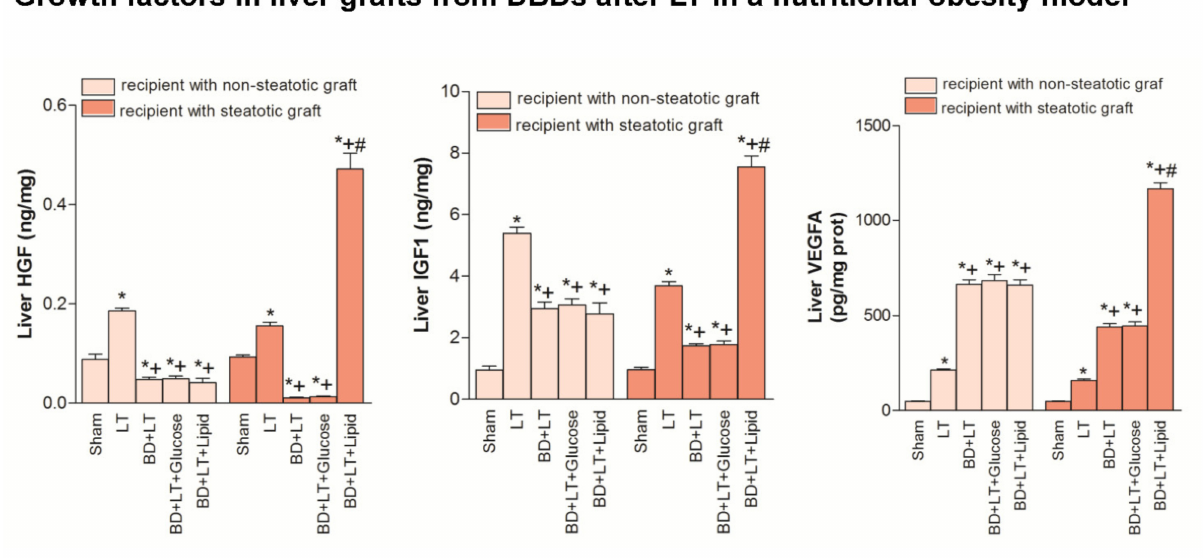
Figure 7. Effects of glucose and lipids on growth factors in steatotic and non-steatotic LT in a nutritional obesity model. HGF, IGF1 and VEGFA in liver. * p < 0.05 vs. Sham. + p < 0.05 vs. Liver Transplantation (LT). # p < 0.05 vs. Brain death+ Liver Transplantation (BD + LT). DBD, Donors after Brain